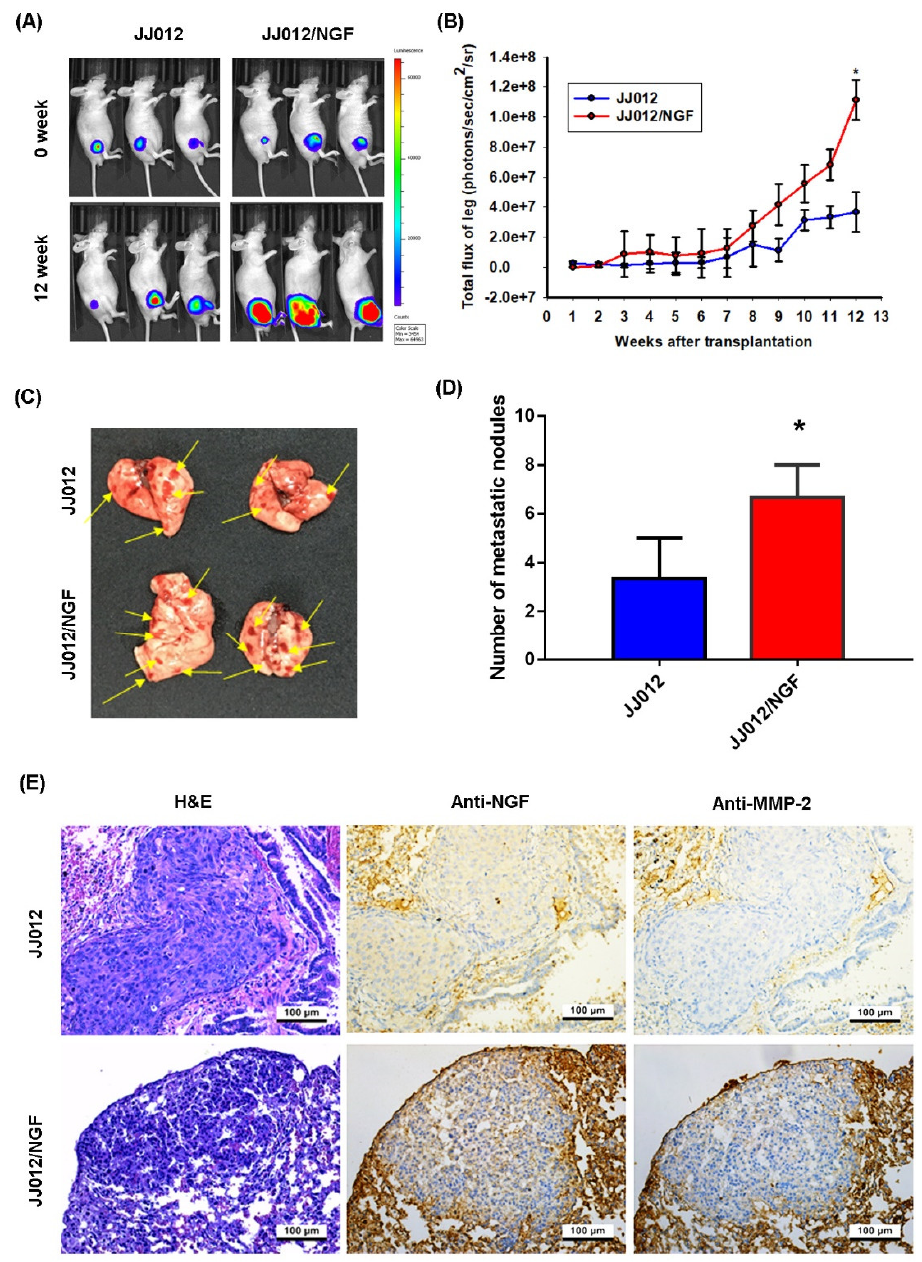
Figure 6. NGF promotes chondrosarcoma metastasis to the lungs in vivo. ( A , B ) The mice were injected with JJ012 or JJ012/NGF cells. The lung metastasis was monitored by bioluminescence imaging at the indicated time intervals then quantified by photon images. ( C , D ) After 12 weeks, the mice were humanely sacrificed and the lung tissue was excised, photographed and quantified. ( E ) The levels of NGF and MMP-2 expression in the lung tumors were subjected to an IHC analysis. * p < 0.05 compared with the control group; # p < 0.05 compared with the NGF-treated group.